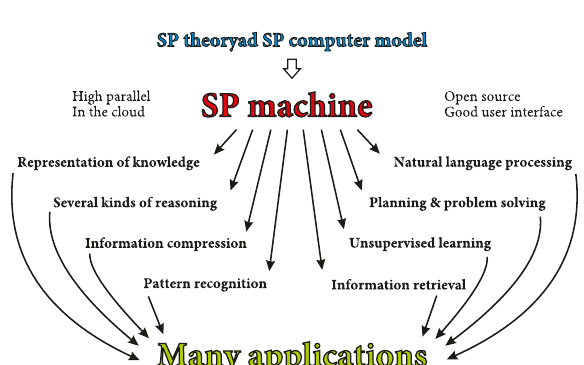
Figure 5: Schematic representation of the development and ap- plication of the SP machine (reproduced from Figure 2 in [21], with